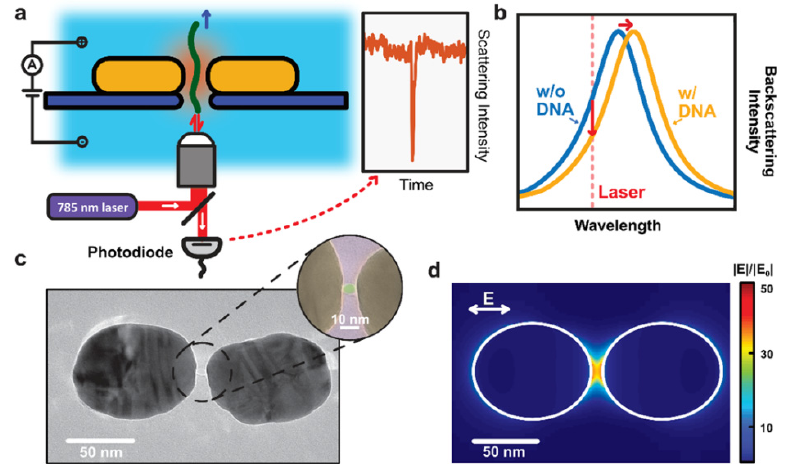
Figure 6. Plasmonic nanopores for single-molecule optical sensing. ( a ) Schematic side-view illustration of a DNA molecule that is electrophoretically driven through a plasmonic nanopore and detected by optical backscattering from the plasmonic antenna. ( b ) Illustration of the sensing principle. The temporary presence of the DNA in the hotspot region of the plasmonic antenna induces a shift of the resonance wavelength of the antenna, hence decreasing the scattering intensity that is detected at the excitation laser wavelength. ( c ) Transmission electron microscopy (TEM) image of the plasmonic nanopore devices used in the experiments. The plasmonic nanopore consists of a gold dimer antenna with a ~5 nm nanopore at the gap center. The inset shows a false colored TEM image of a zoom of the nanogap region, highlighting the nanopore. ( d ) Simulated electromagnetic field distribution of the plasmonic nanopore in longitudinal excitation with a wavelength of 785 nm. The simulation shows the extremely enhanced and confined electromagnetic field within the gap of the dimer antenna, which is required for label-free optical sensing of single molecules. Reprinted with permission from Shi et al. [37] Copyright © 2018 American Chemical Society.